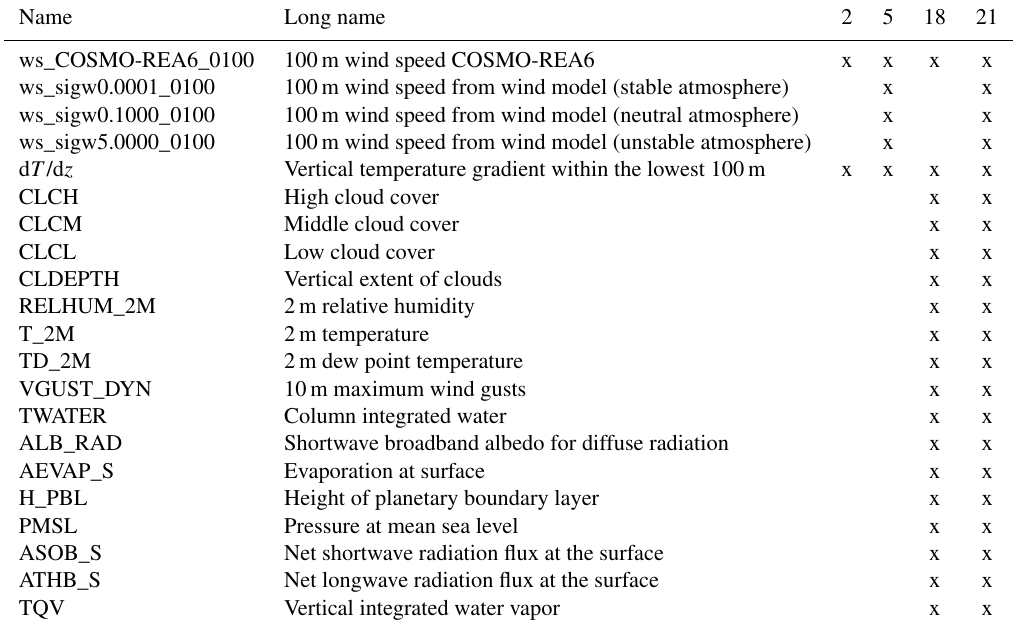
Table 3. COSMO-REA6 and wind model variables used in the statistical models with 2, 5, 18 and 21 predictors. Name Long